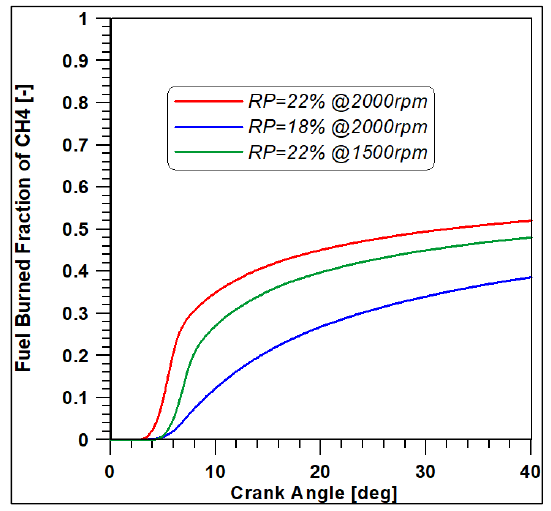
Figure 16. Methane burned fraction for RP = 22 and 18% at 2000 rpm .